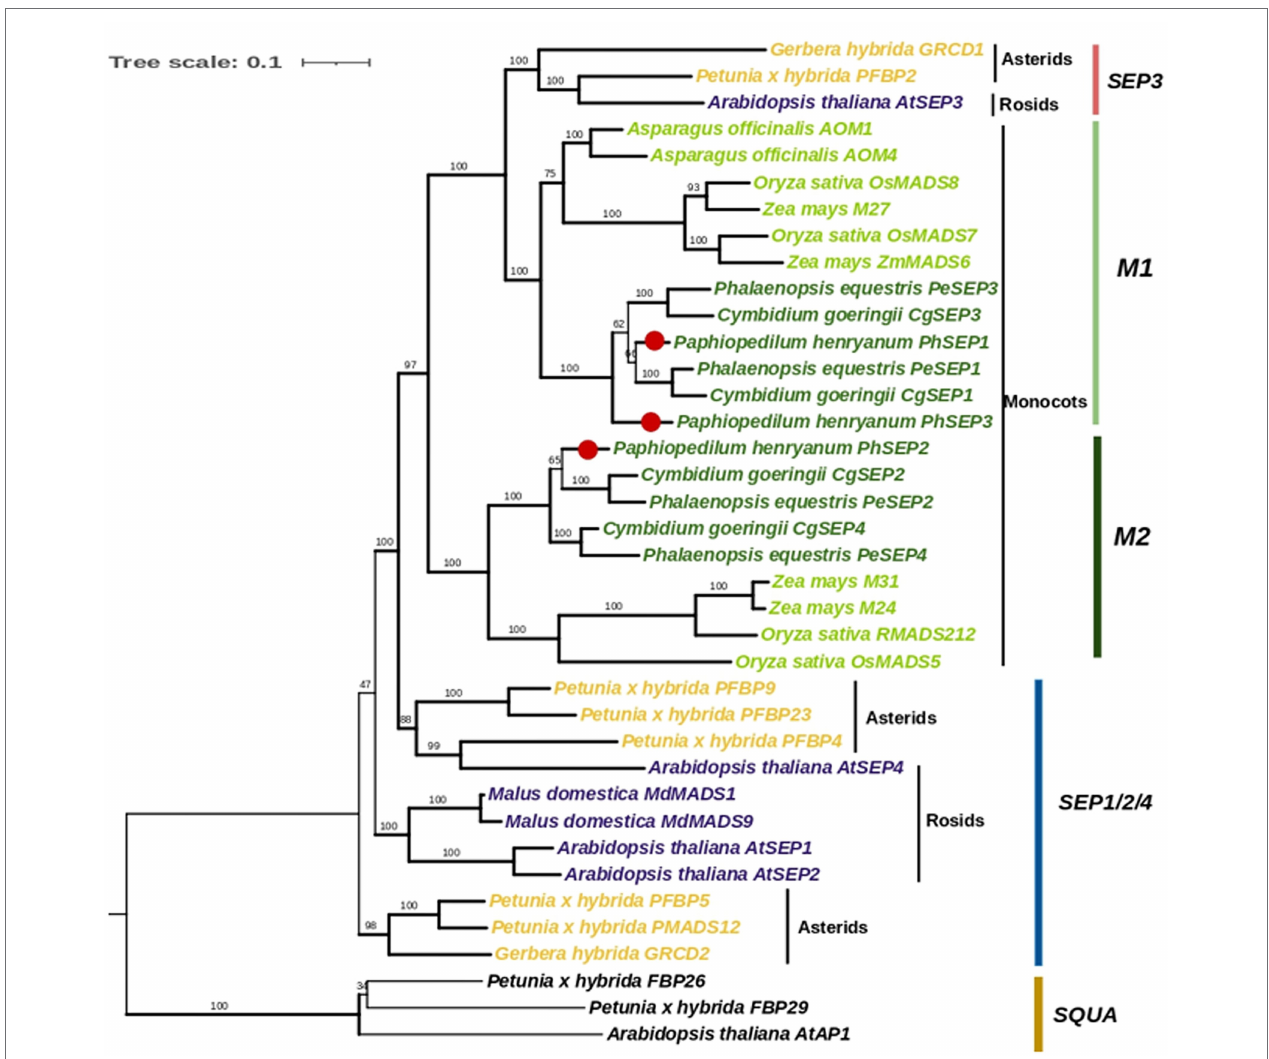
FIGURE 3 | Phylogenetic analysis of SEP -like genes with SQUA genes as an outgroup. The topology of this tree was generated using PhyML. ML bootstrap support (MLBS) values are indicated on each branch. Thick branches indicate high support values with MLBS ≥ 70. PhSEPs are marked with red